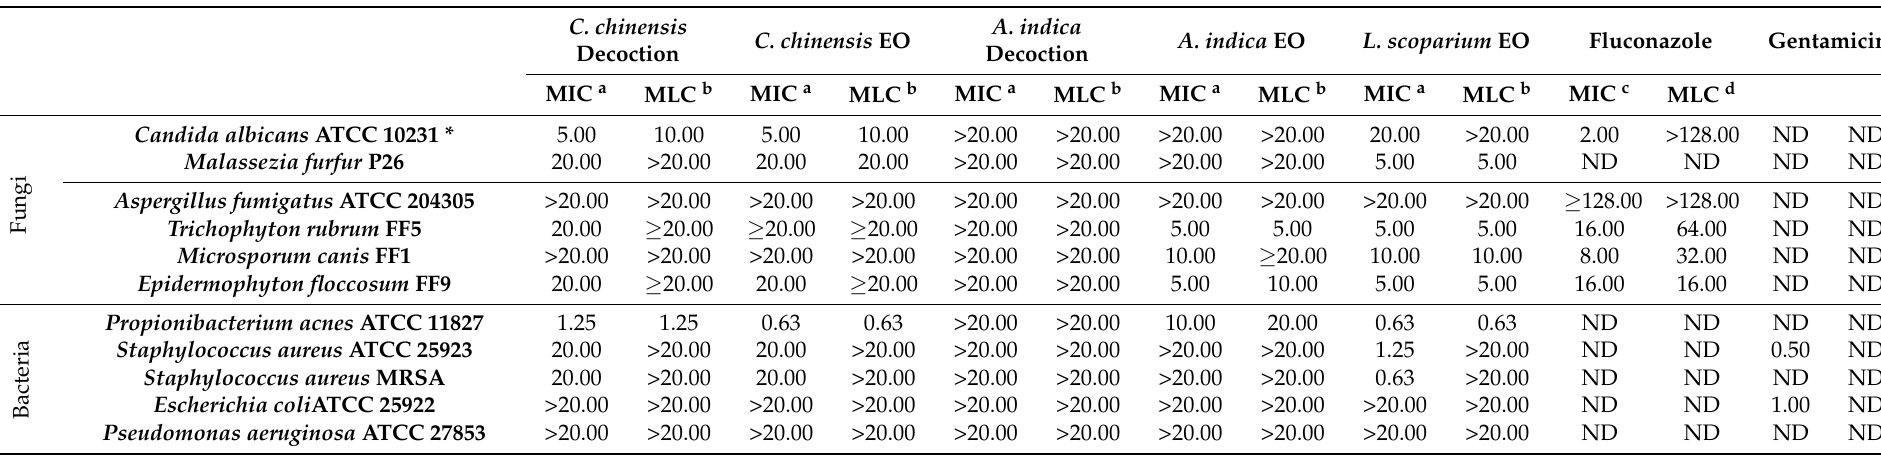
Table 1. Antimicrobial activity (minimum inhibitory and lethal concentration, MIC/MLC) of Coptis chinensis and Azadirachta indica decoctions/EO and Leptospermum scoparium